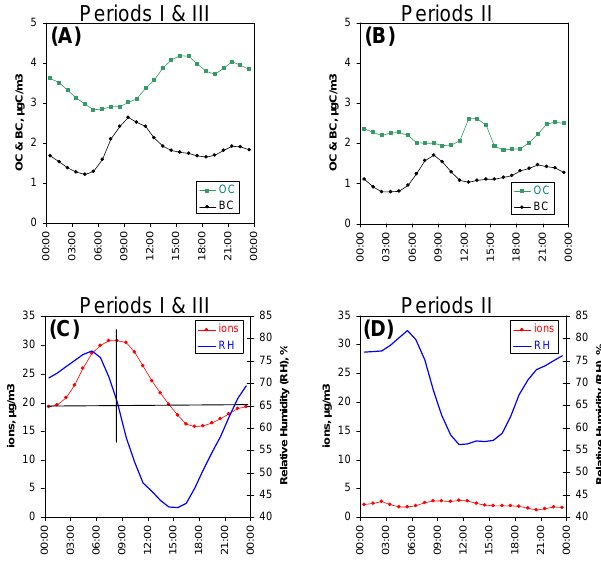
Fig. 6. Diurnal variations of BC and OC concentrations for periods I and III (A) and period II (B) . Diurnal variations of ions concentra- tions (derived from Eq. 2) and relative humidity (RH) for periods I and III (C) and period II (D)